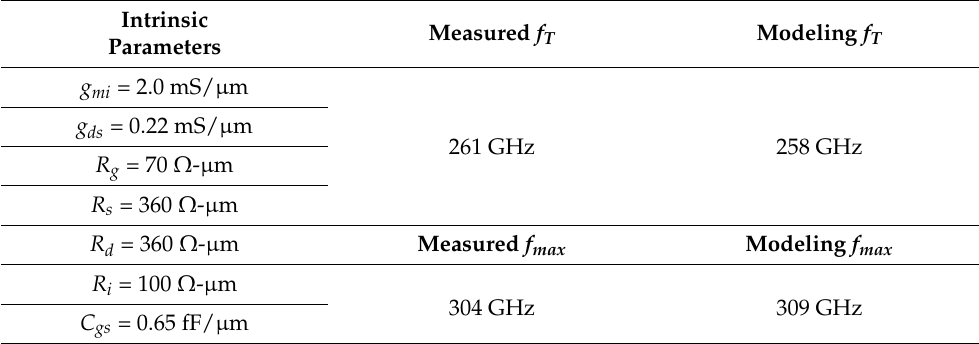
Figure 4. ( a ) Comparison of small-signal modeling and measured S-parameters at V DS = 0.5 V and V GS = 0.2 V. A Smith chart of S 11 , S 12 , and S 22 (left) and a polar chart of S 12 (right). ( b ) Measured (symbols) and modeled (solid lines) of RF gains-Maximum oscillation frequency ( f max ), maximum stable gain (MSG)/maximum available gain (MAG), and unity current gain cutoff frequency ( f T ) of the mHEMTs at V DS = 0.5 V and V GS = 0.2 V. Table 1. Extracted intrinsic small-signal parameters. Table 1. Extracted intrinsic small-signal parameters.